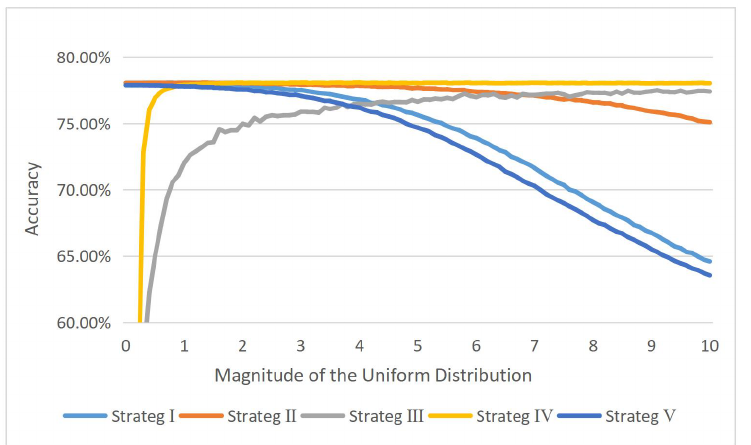
Figure 2. The average classification accuracy of Inc_v3, Inc_v4, IncRes_v2, and Xcep integrated with five different feature transformation strategies on ImageNet. The horizontal coordinate is the magnitude of uniform distribution and the vertical coordinate is the accuracy of the